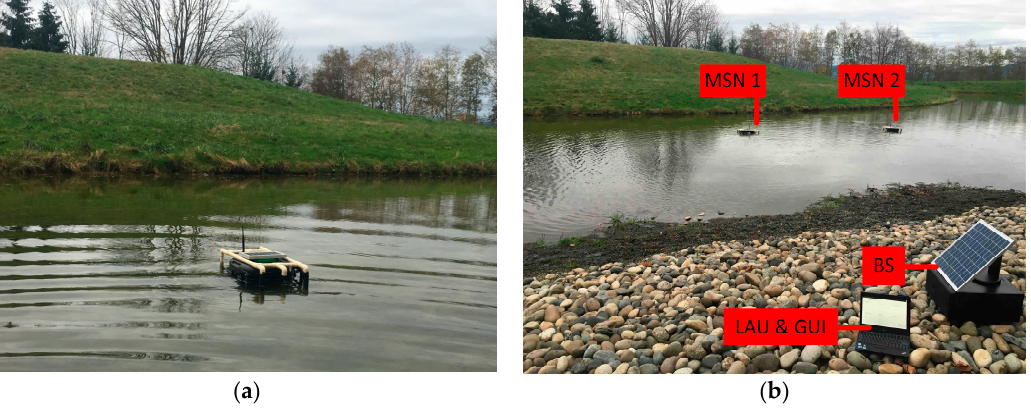
Figure 6. Field deployment of the developed platform at the Yosef Wosk Reflecting Pool: ( a ) Deployment of the MSN in the pool; ( b ) Deployment of the platform in the field.